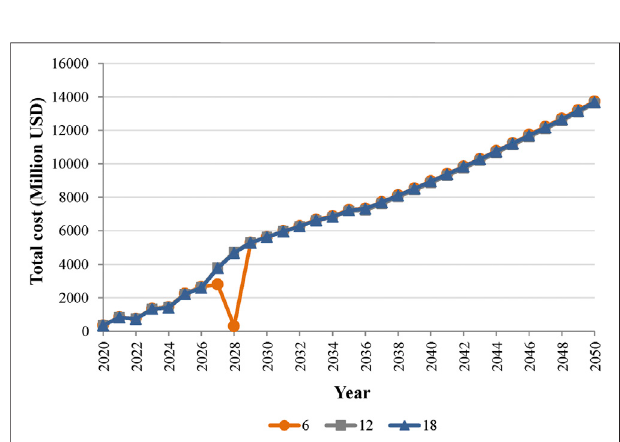
FIGURE 11 | Total cost changes under different carbon permit